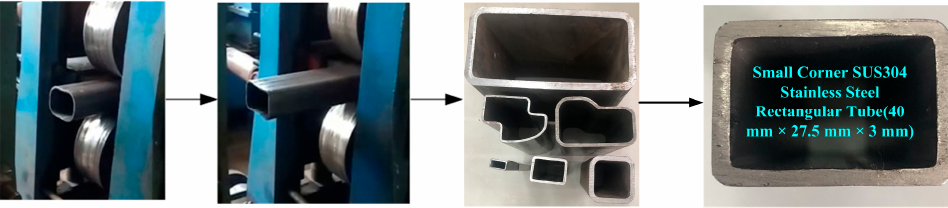
Figure 14. Roll forming test of shaped tube.